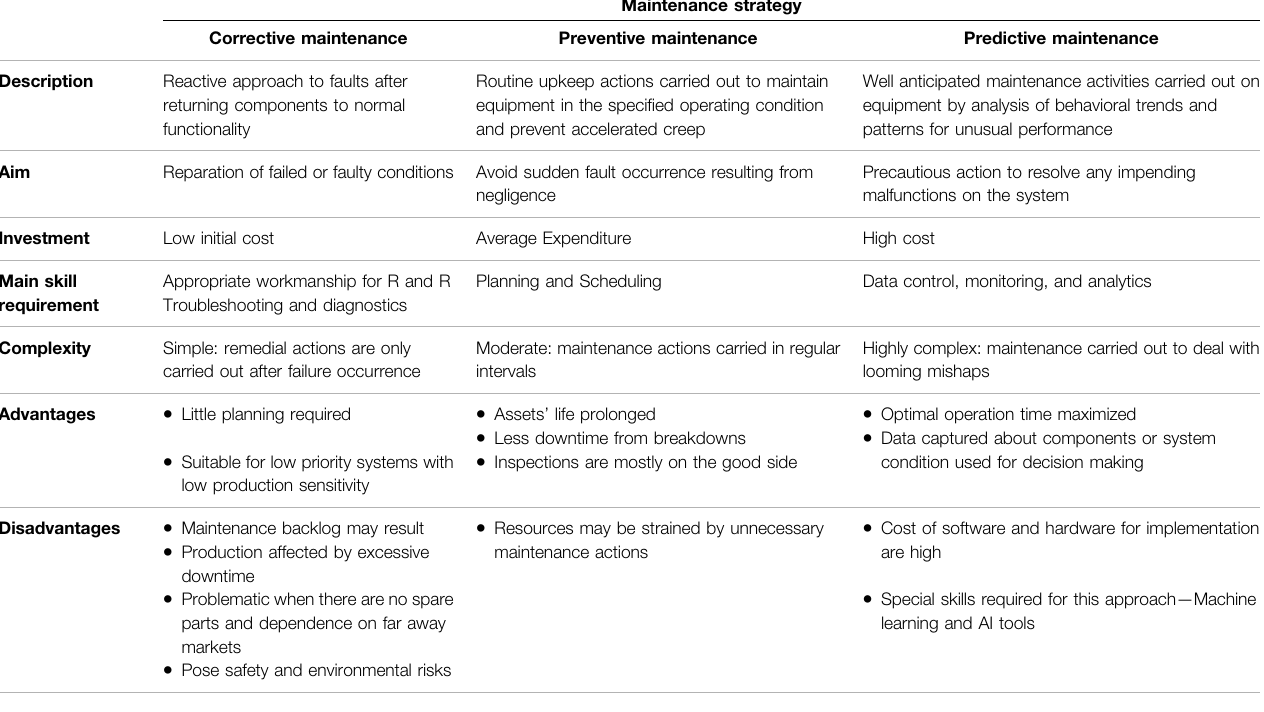
TABLE 1 | Summary of types of maintenance strategies.